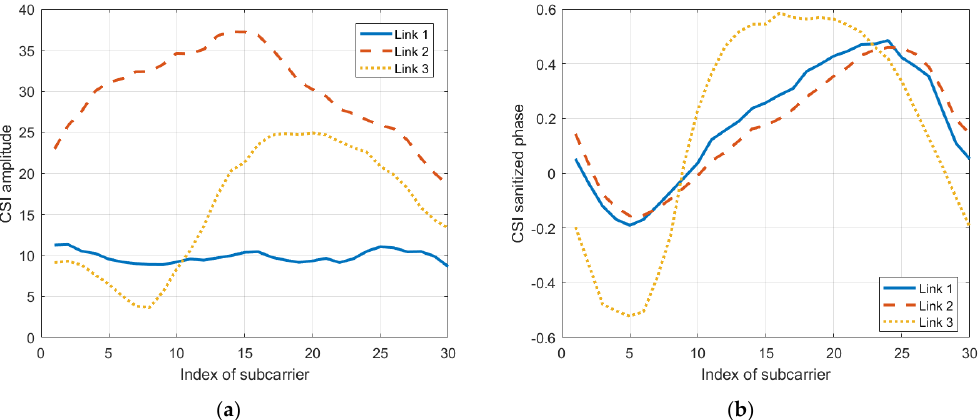
Figure 8. The mean vectors of ( a ) the CSI amplitude and ( b ) the CSI sanitized phase from 3 different communication links.